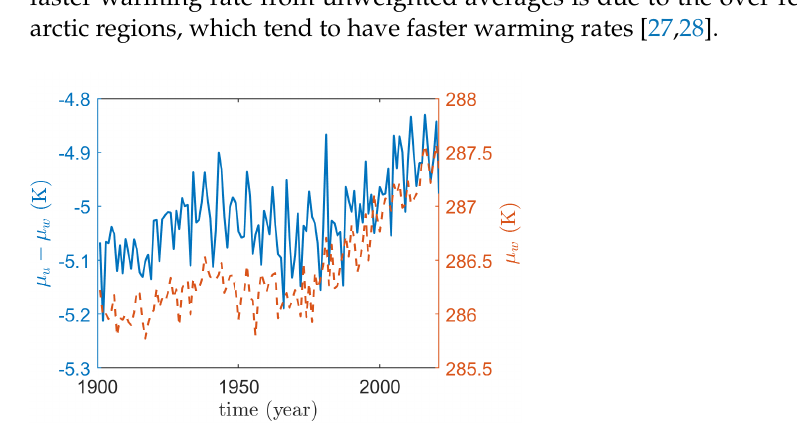
Figure 4. Differences of weighted and unweighted averages of global temperature ( µ u − µ w ). Time series of global mean temperature µ w is also shown for